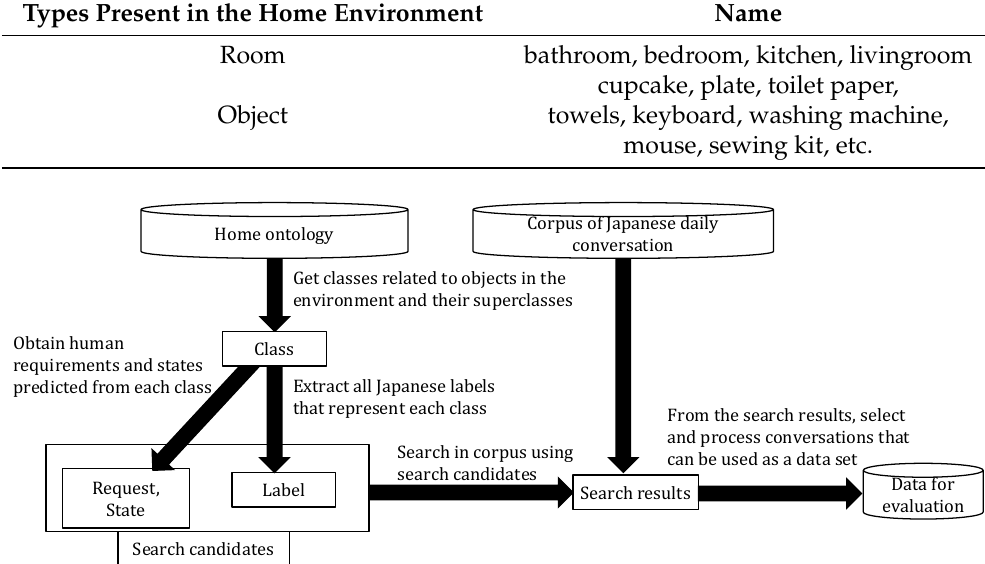
Table 3. Part of the objects and room options present in the home environment used in the evaluation experiment.